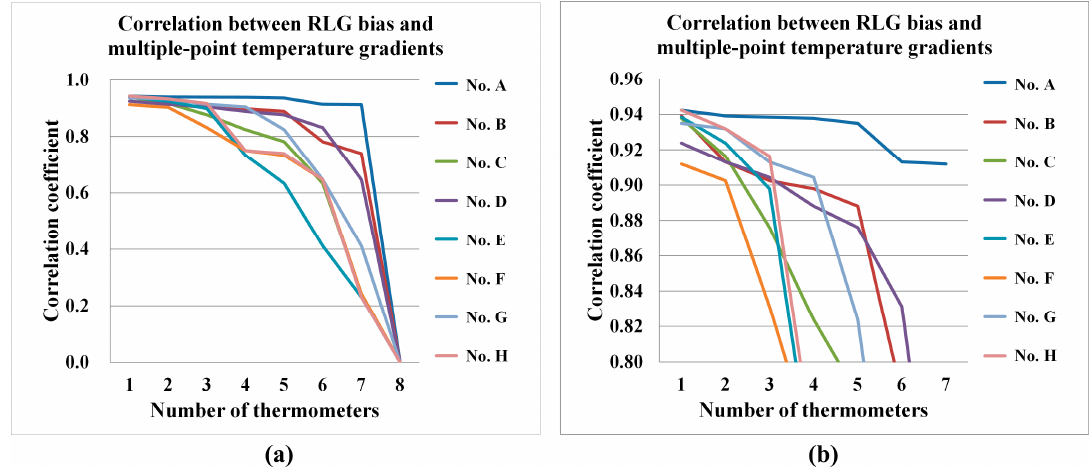
Figure 5. ( a ) Correlation analysis between the RLG bias and multiple-point temperature gradient algorithm; ( b ) Enlarged figure obtained from ( a ).